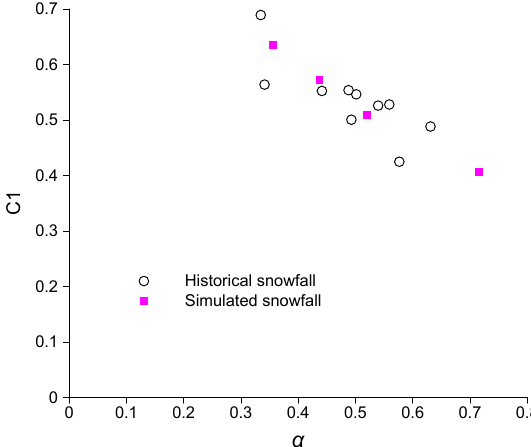
Fig. 8. Realizations of daily distributions of monthly snowfall for Saskatoon, February, 2006. Fig. 9. Mean values of α and C1 computed for all 10 section of the Saskatoon daily snowfall time series and from simulated daily snowfall data downscaled from measured monthly